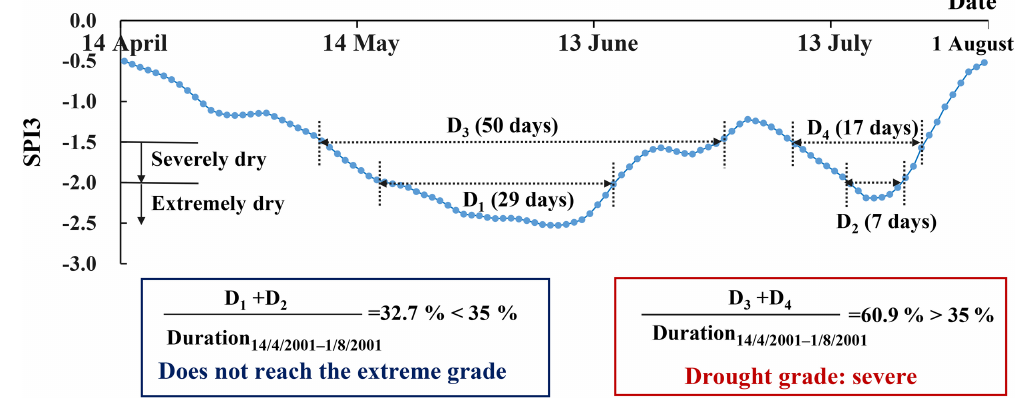
Figure 4. An example of grade classification for one complete drought process: the 2001 summer drought in northern China.